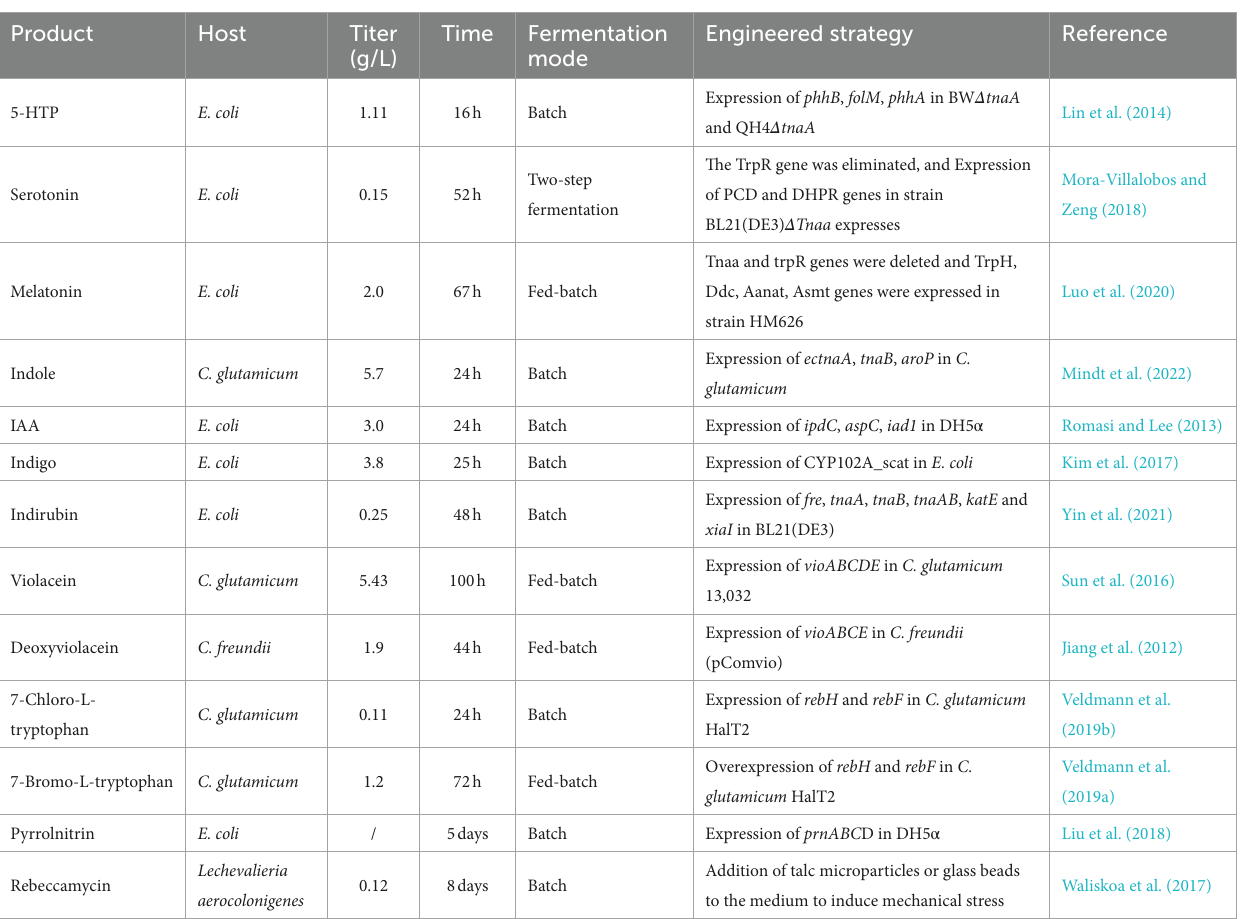
TABLE 1 Biosynthesis of tryptophan